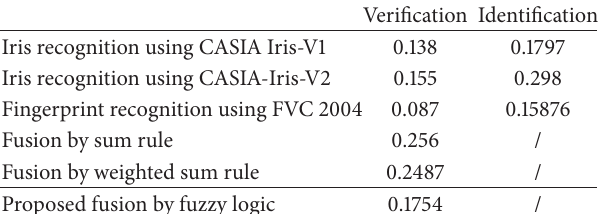
Table 1: Matching time comparison. Verification